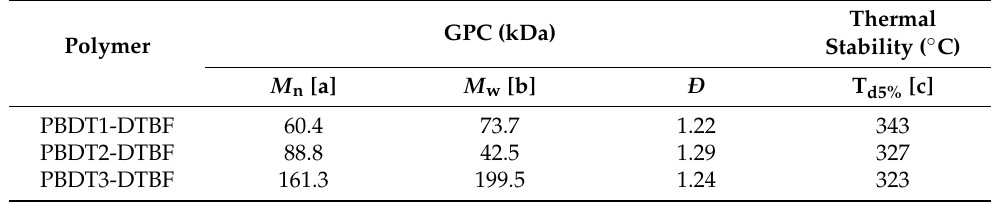
Table 1. Molecular weight and thermal stability of PBDT1-DTBF, PBDT2-DTBF and PBDT3-DTBF.